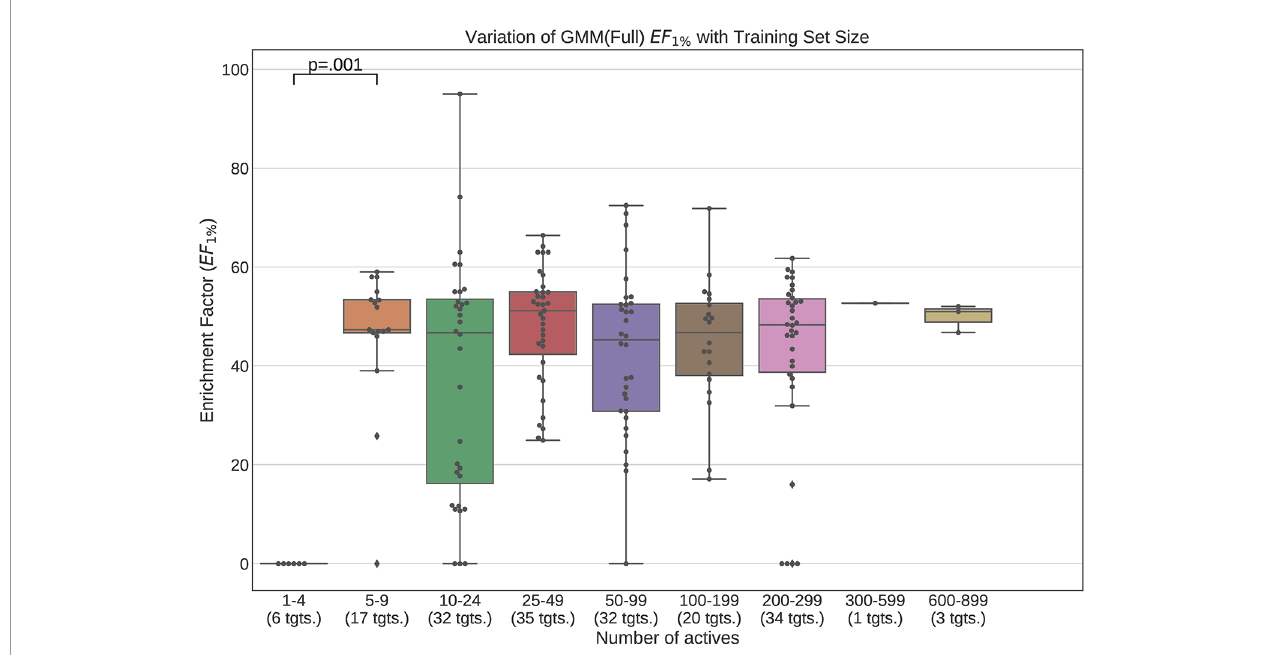
FIGURE 12 | Performance variation of full-conformer model Gaussian Mixture Models with number of actives. Scatter plot indicates one point per template within the given range. The number of templates captured within the range is indicated in the axis labels. Note that multiple points belonging to the same target could fall within a single range due to the binning thresholds used.